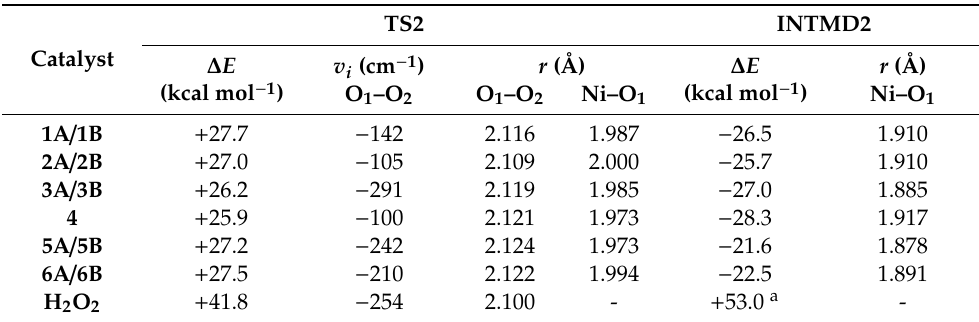
Table 6. Selected structural data of transition states (TS2) and active intermediates (INTMD2) for the